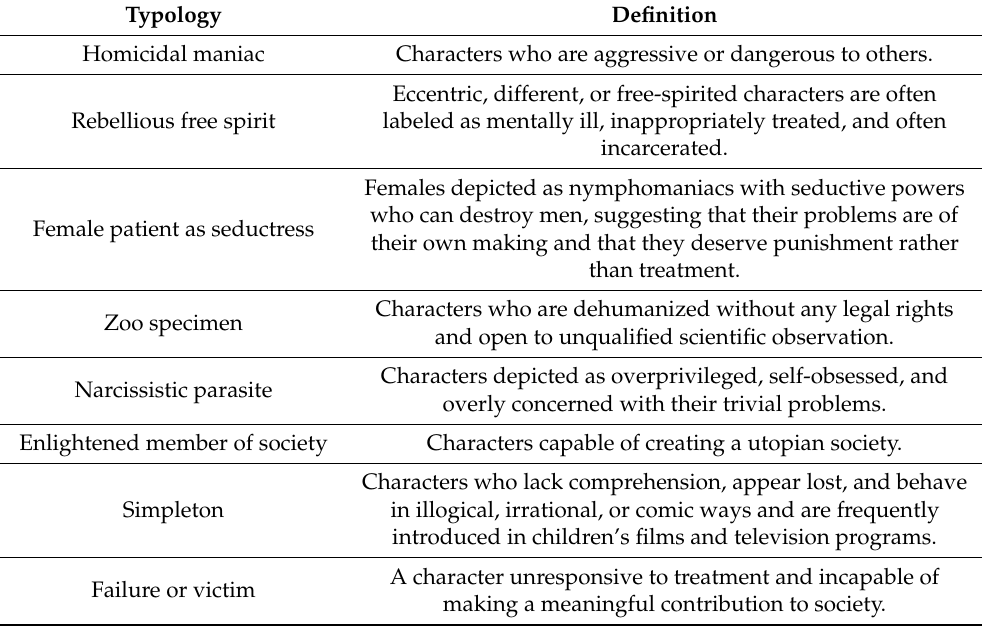
Table 1. Typology of patients. Sources: Schneider (1987) and Pirkis et al.